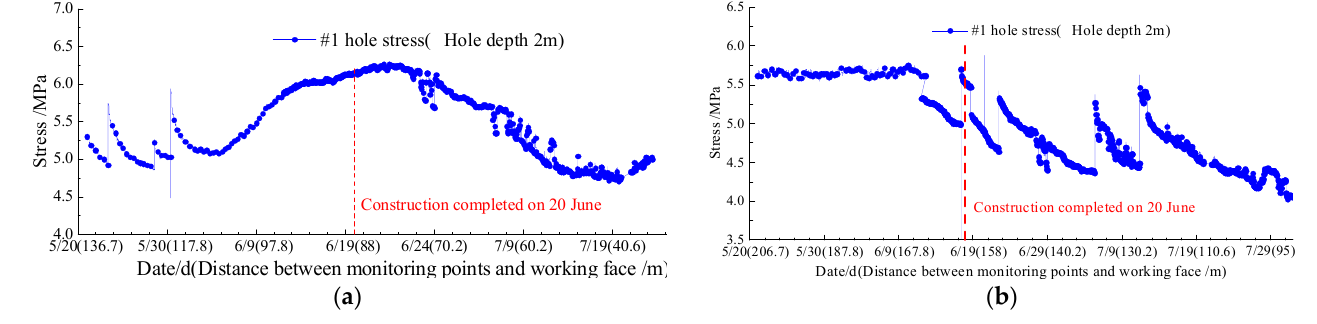
Figure 13. Stress monitoring data of small coal pillar; ( a ) #1 stress detector data; ( b ) #2 stress detector data.